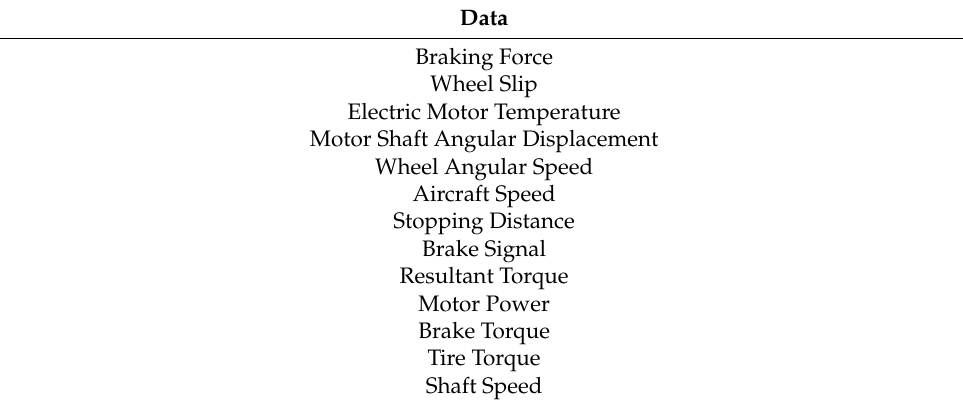
Figure 1. Overview of the EBS Model ( a ) ABS Control Layer; ( b ) EMA and Actuator Controller Layer. Table 2. Data Obtained from EBS